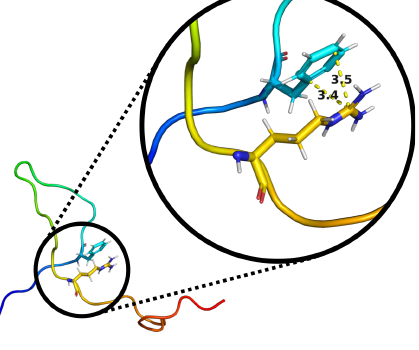
Figure 6. Illustration of cation– π interaction between Phe-6 and Arg-20 in MD 3 structure. marked distances given in Ångström